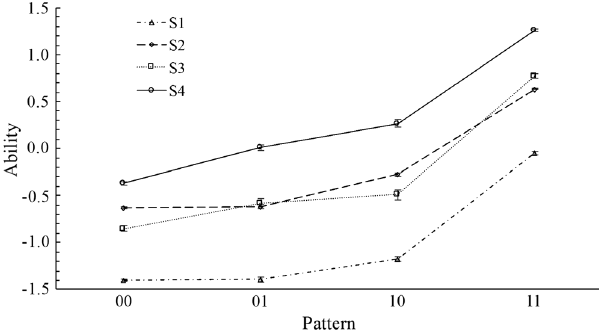
FIG. 1. Average students ’ abilities of the four response patterns. The students ’ abilities are all estimated using M1 with all four populations combined to allow a consistent